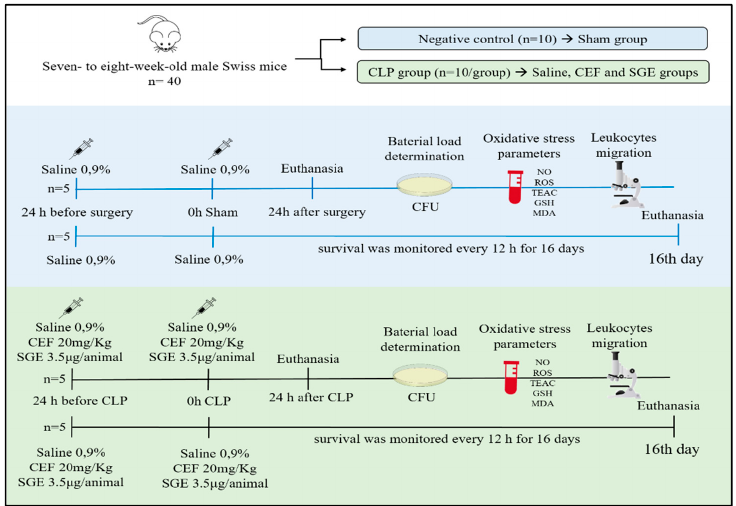
Figure 1. Experimental protocol of the CLP model and pre-treatments. CLP: cecal ligation and puncture; CEF: ceftriaxone; CFU: colony-forming unit; ROS: reactive oxygen species; SGE: salivary gland extract; TEAC: Trolox equivalent antioxidant